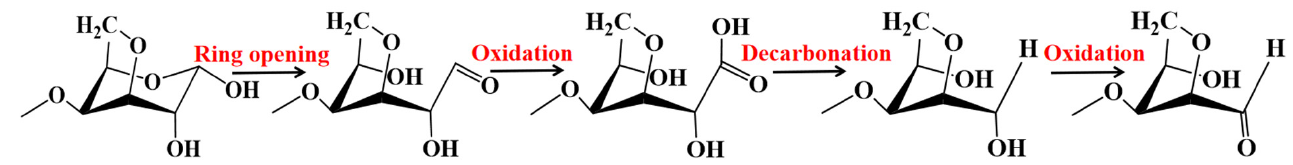
Table 2. Relative contents of κ -carrageenan oligosaccharides detected in DC-6.